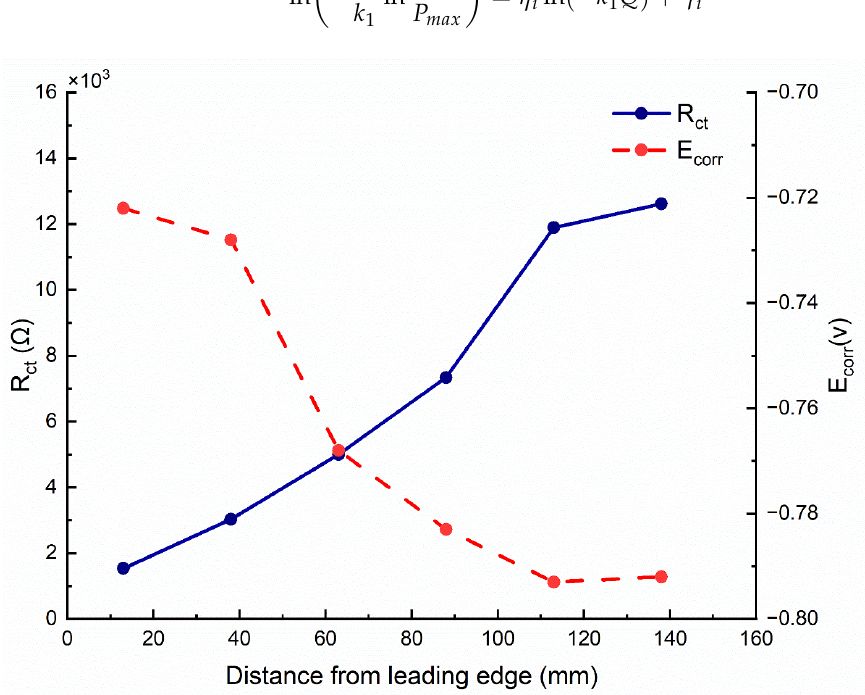
Figure 11. Variations of E corr and R ct with distance from the leading-edge (in y-direction).